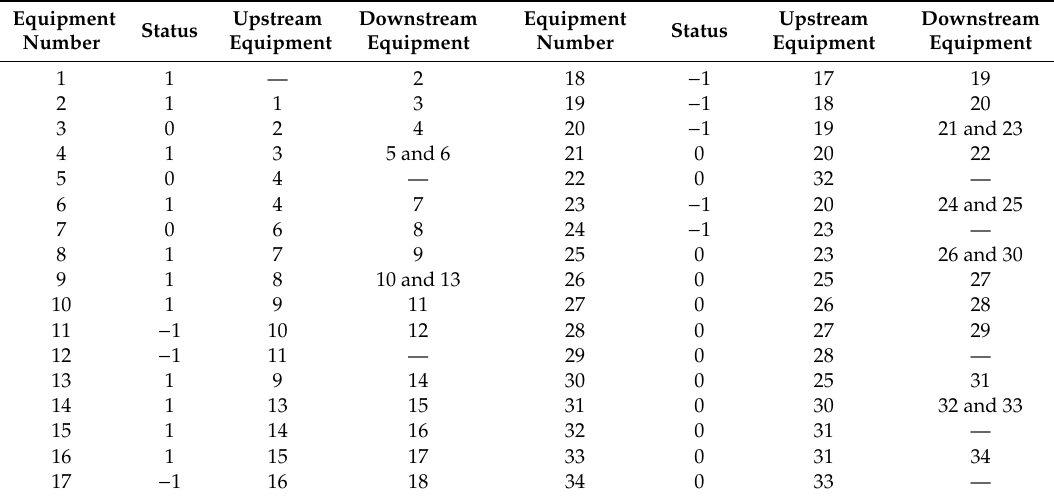
Table 8. The line list of Figure 11.